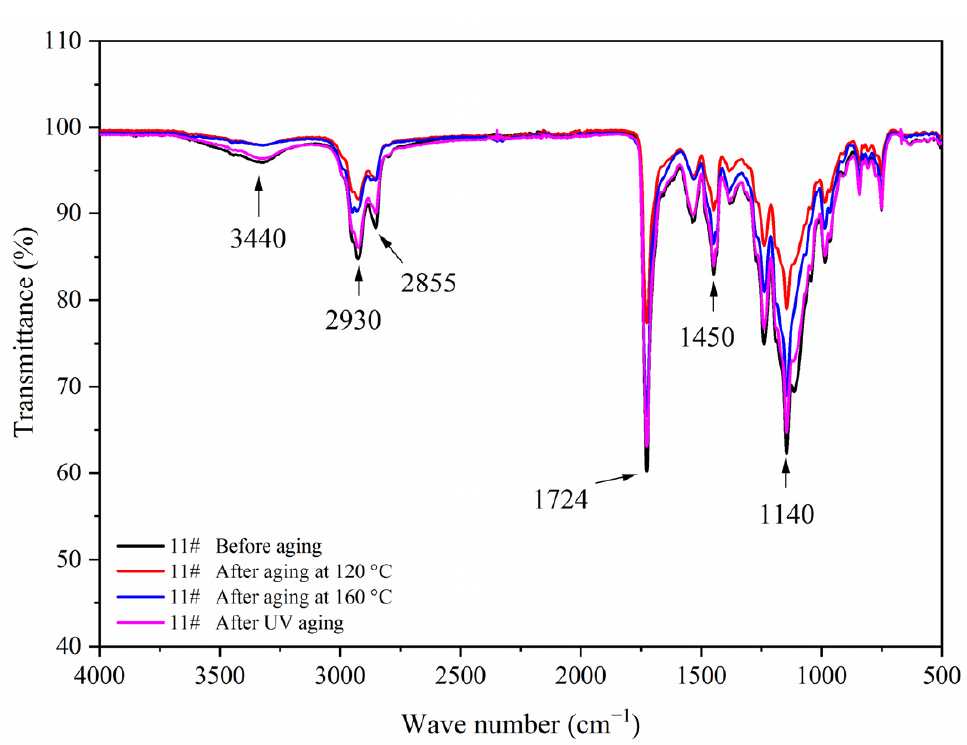
Figure 19. FTIR of sample 11# before and after aging.